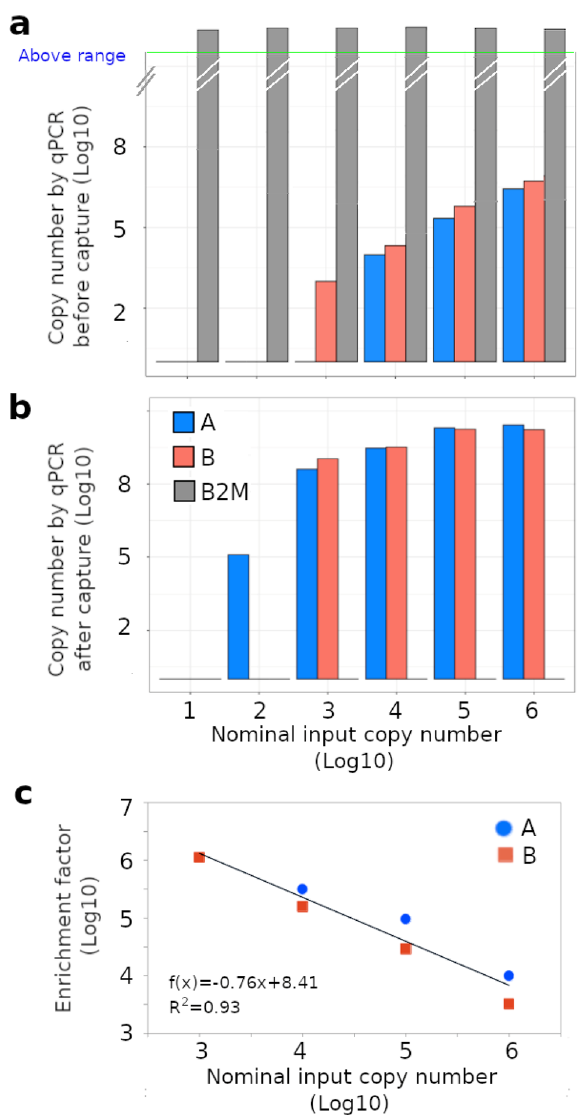
genomic DNA to simulate a clinical sample background. Copy number was measured by real-time qPCR, for probes A and B as well as for a human housekeeping gene B2M, both before ( a ) and after ( b ) capture. Notably, B2M copy numbers were above-range before capture and undetectable after capture. ( c ) Enrichment factor is the ratio of copy numbers before and after